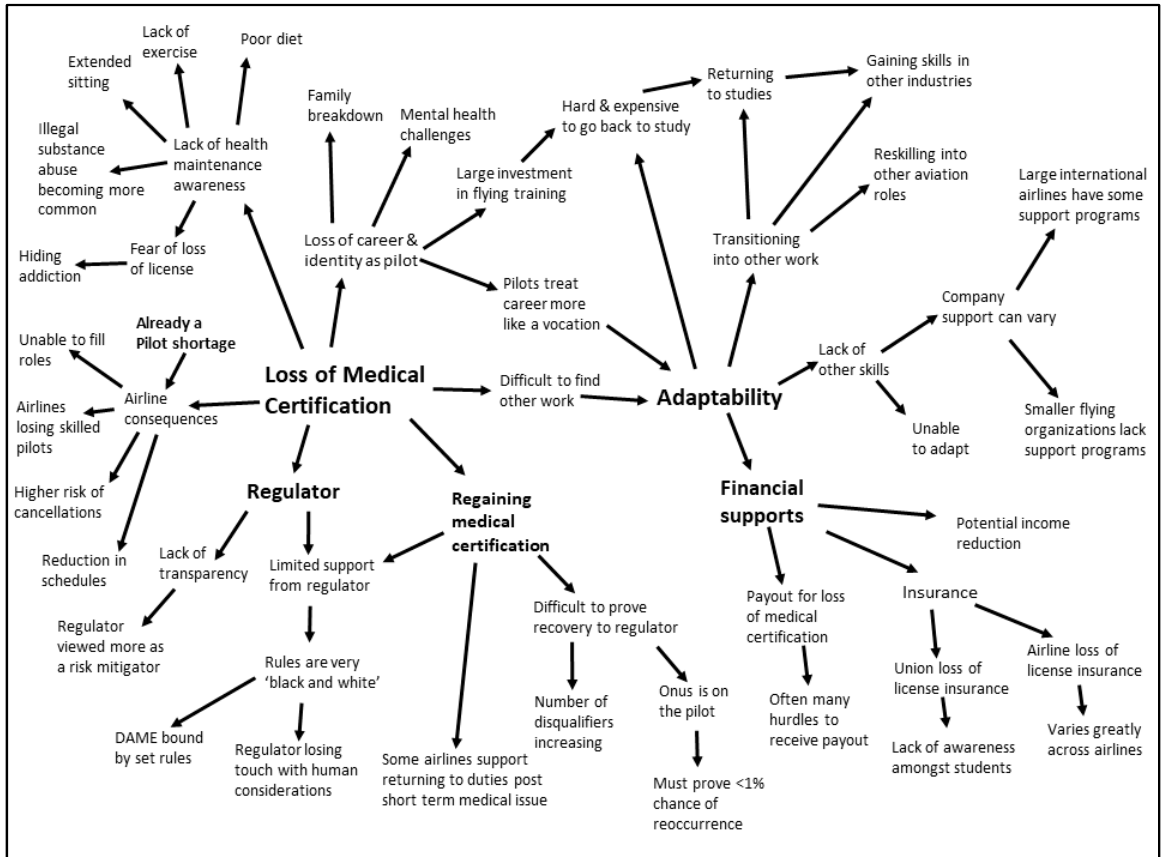
Figure 1. An a ffi nity diagram summarizing the results from the convergent